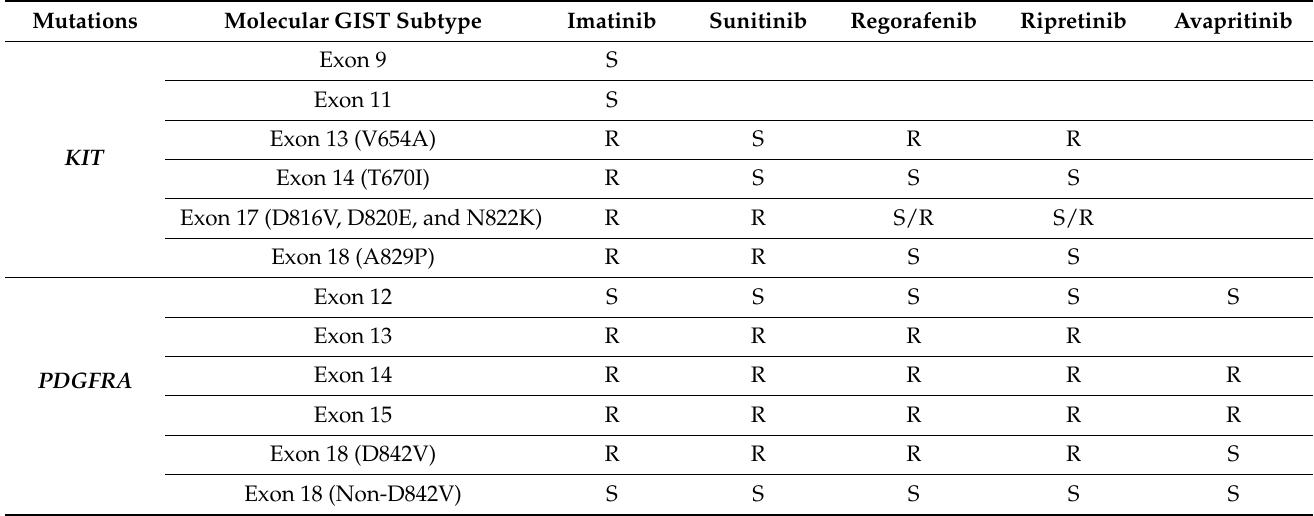
Table 1. Molecular subtypes of GISTs and sensitivity to